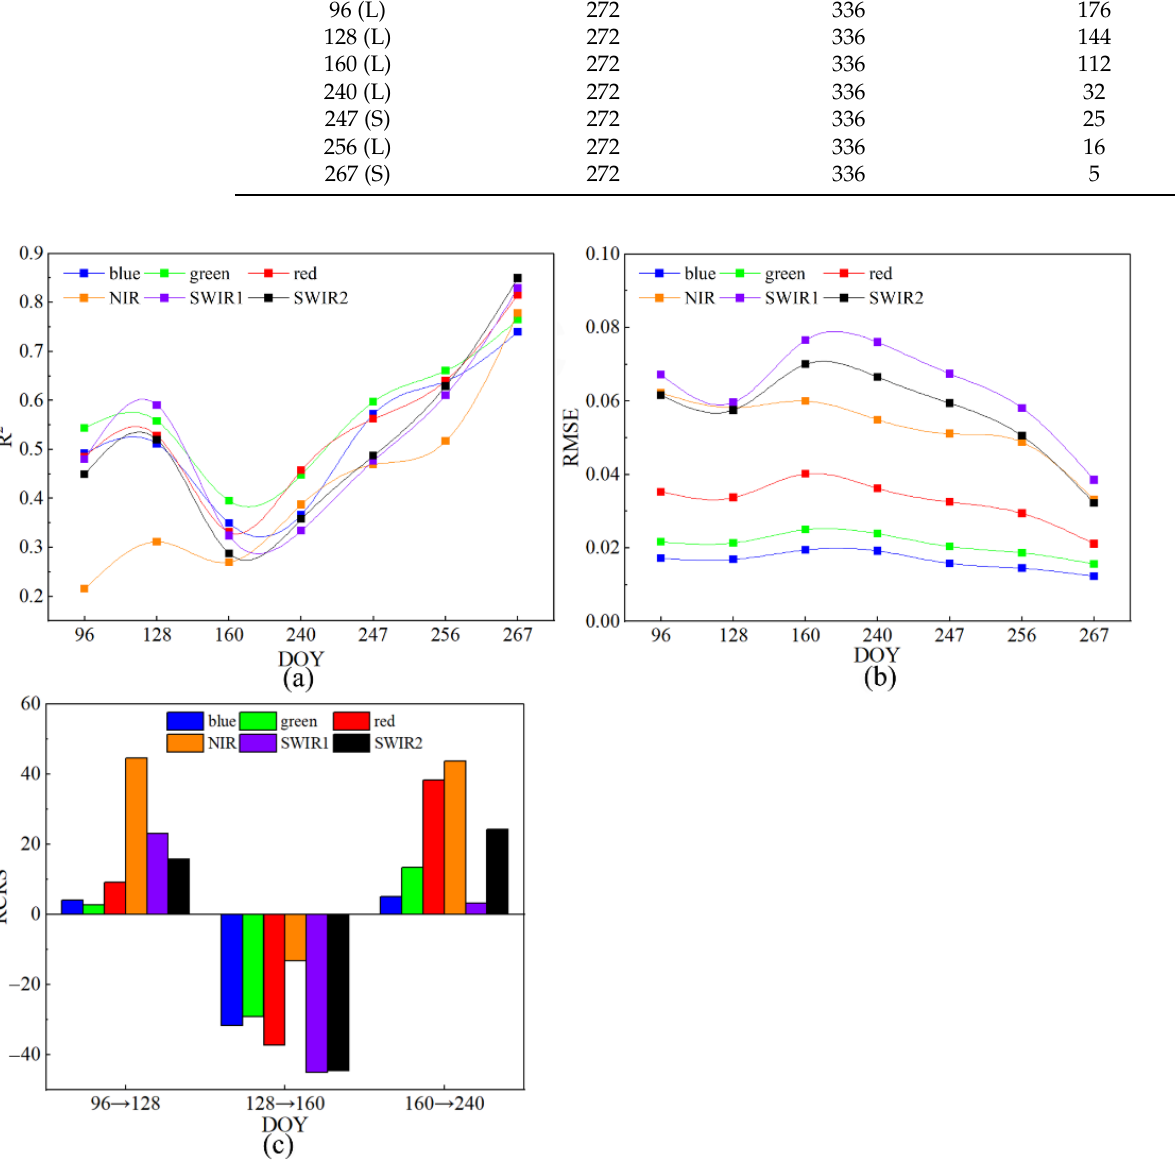
Figure 11. Accuracies of the fused images with different CDs for NMC period. ( a ) R 2 , ( b ) RMSE, and ( c ) RCRS (The horizontal axis indicates the DOY of the input CD image pairs for ( a , b ), and the change of DOY for ( c ); the vertical axis indicates the values of R 2 , RMSE, and RCRS, respectively).